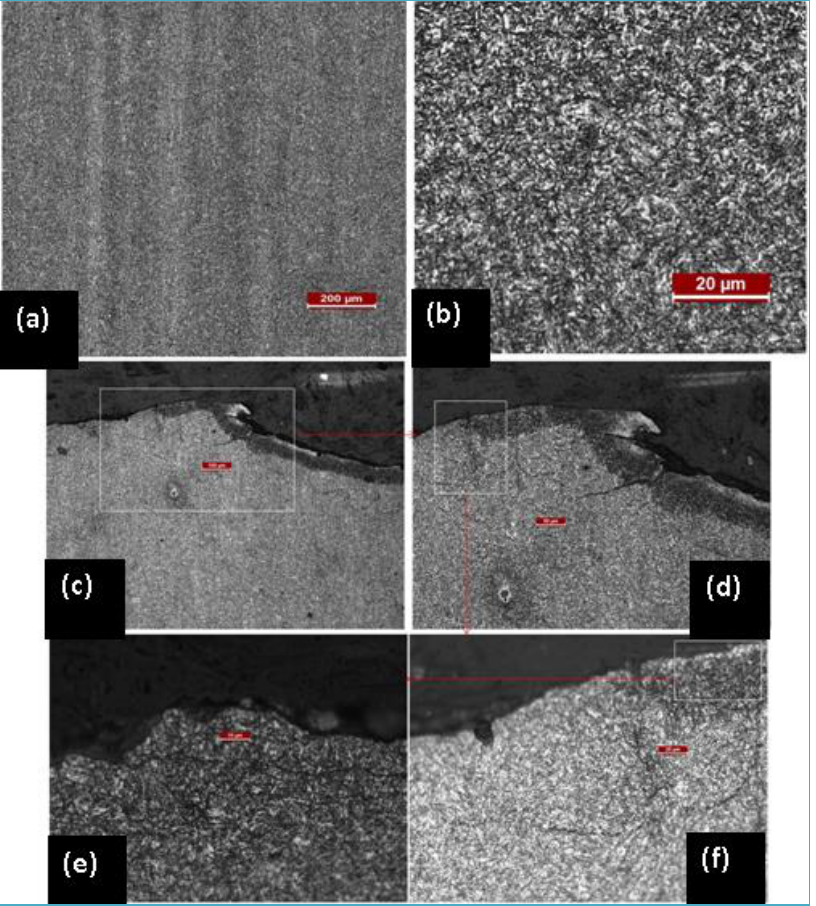
Fig. 10: Optical micrographs of the failed sample: (a) banding and (b-f) tempered martensite structure along with few peripheral cracks. Etchant: 3%